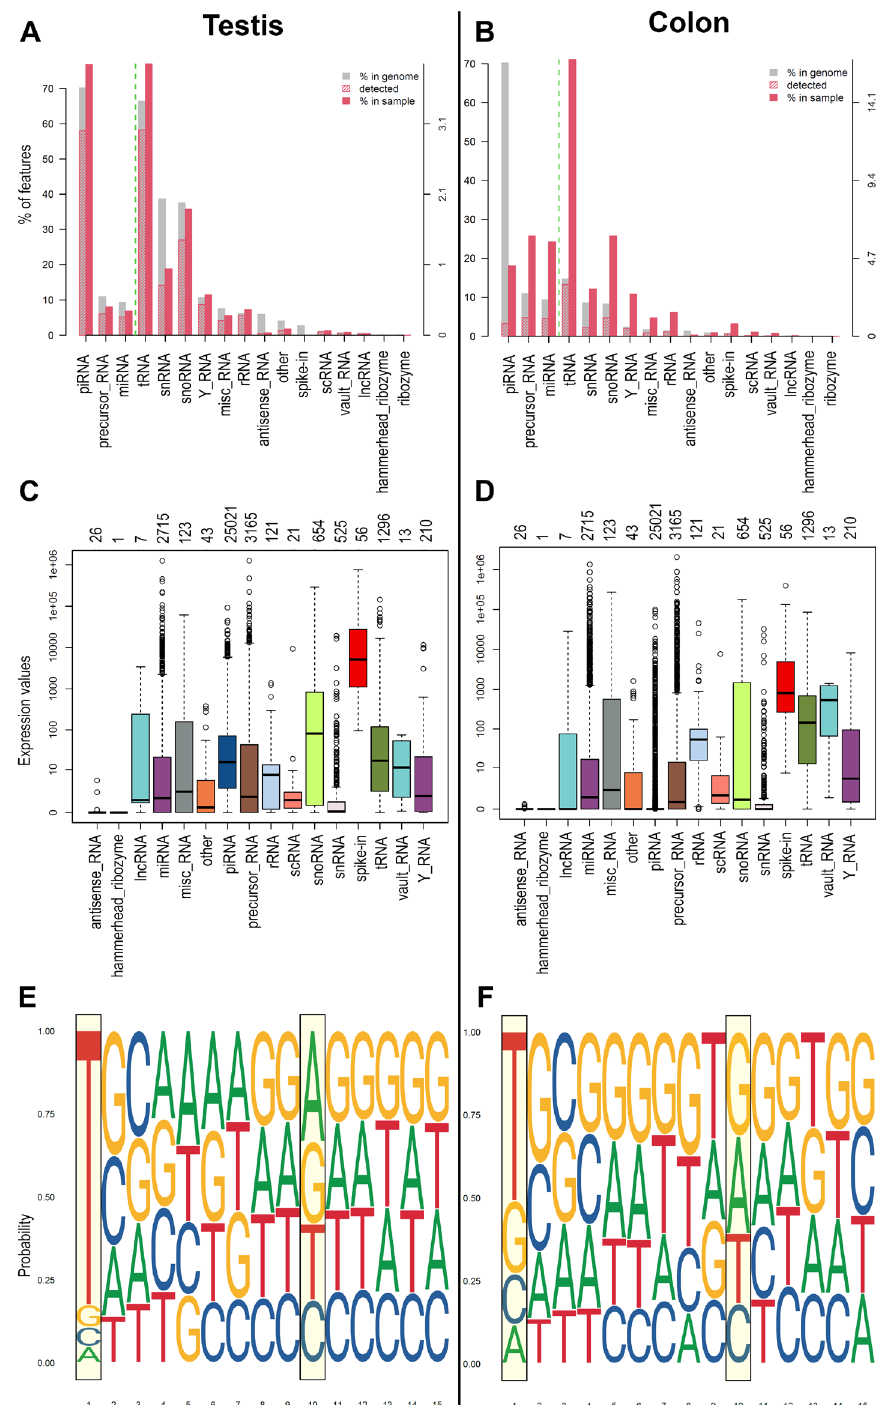
Figure 2. Example of plots generated by WIND. A ) and B ) Biodetection plots (genomic approach) from NOIseq reporting: percentages of each sncRNA type called “biotype” on the genome (grey bar) for one of the samples; the proportion detected in each sample (red stripes bar); the percentage of each biotype within the sample (red bar). The biotypes on the right side of the green dashed line are the least abundant, and the reference values are reported on the Y right axis. C ) and D ) CountsBio plots (genomic approach) from NOIseq showing the count distribution for each biotype displayed as boxplots. Numbers on top of the plot show how many sncRNAs are detected per biotype in the entire dataset analysed. Different colours indicate different sncRNA classes. E ) and F ) Sequence Logo (1-15 bps) extracted from the piRNA sequence of the expressed piRNAs found in each group of samples (transcriptomic approach). A , C , E represents the results obtained for one representative testis samples, while B , D , F represent one representative COLO 205